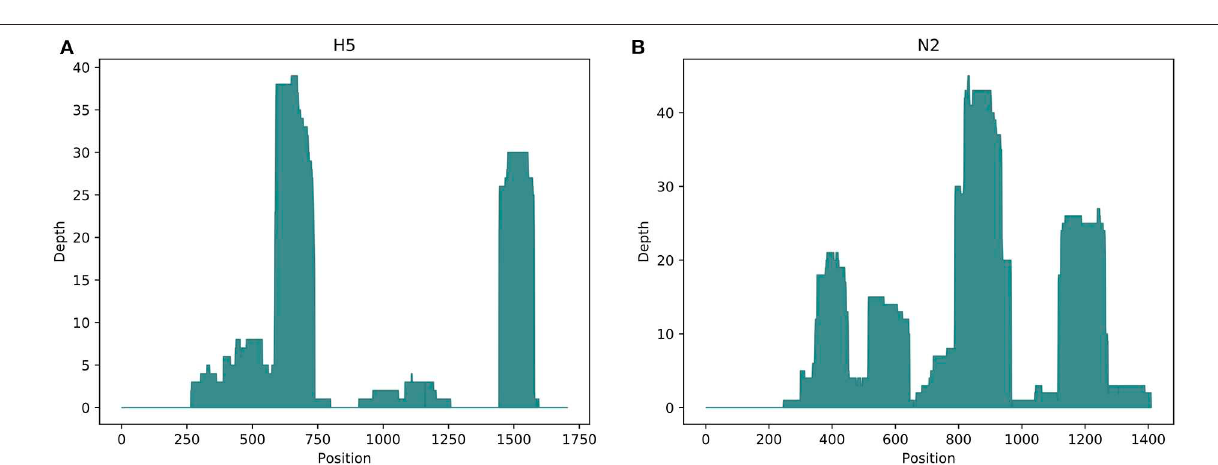
FIGURE 2 | Targeted resequencing depth of coverage for (A) H5 and (B) N2 reference sequences in H5N2 positive controls. The x-axes show the base position for the H5 and N2 reference sequences. Missingness of reads covering portions of the reference sequence indicates parts of the sequence that were not captured by the probes and sequenced.